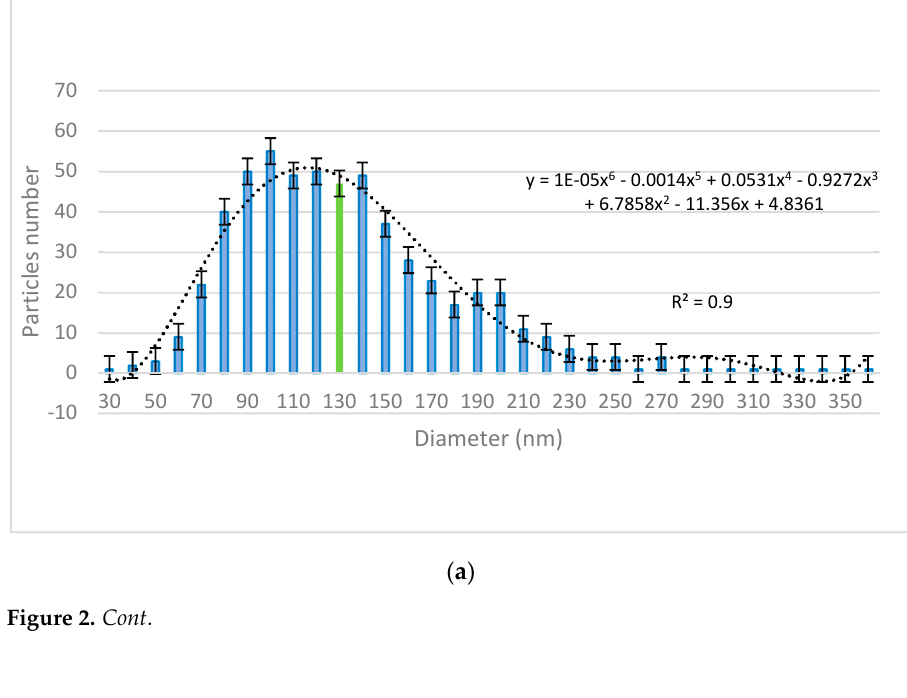
Figure 1. SEM images of the synthesized nanoparticles ( a ) ZnO, ( b ) TiO 2 , and ( c ) zeolite. Table 1. Composition of the decontamination solutions.